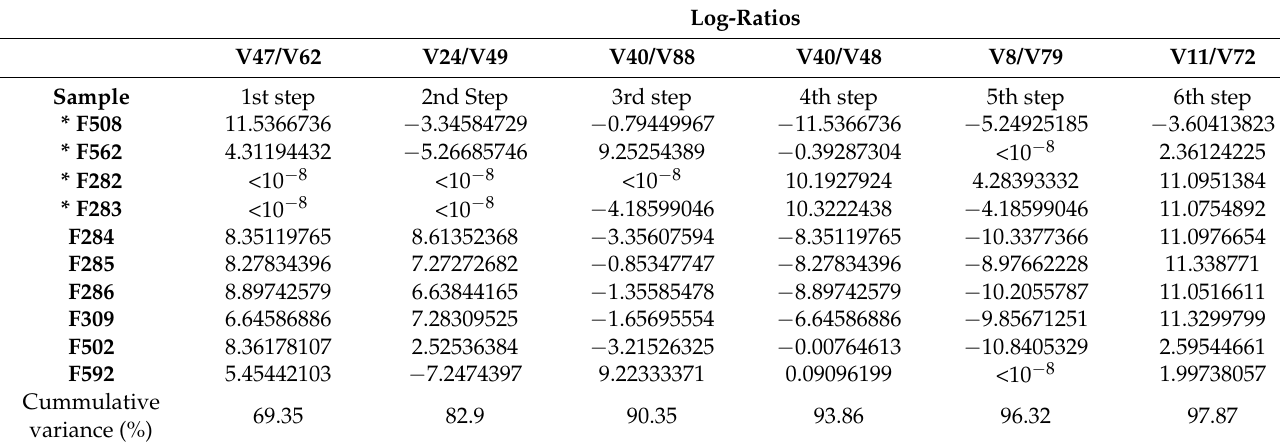
Table 3. Spoiled (*) and normal samples of Spanish-style Manzanilla table olives fermentations. Most influential VOCs’ logratios progressively selected by the function STEP of the easyCODA package, and their cumulative proportions of explained